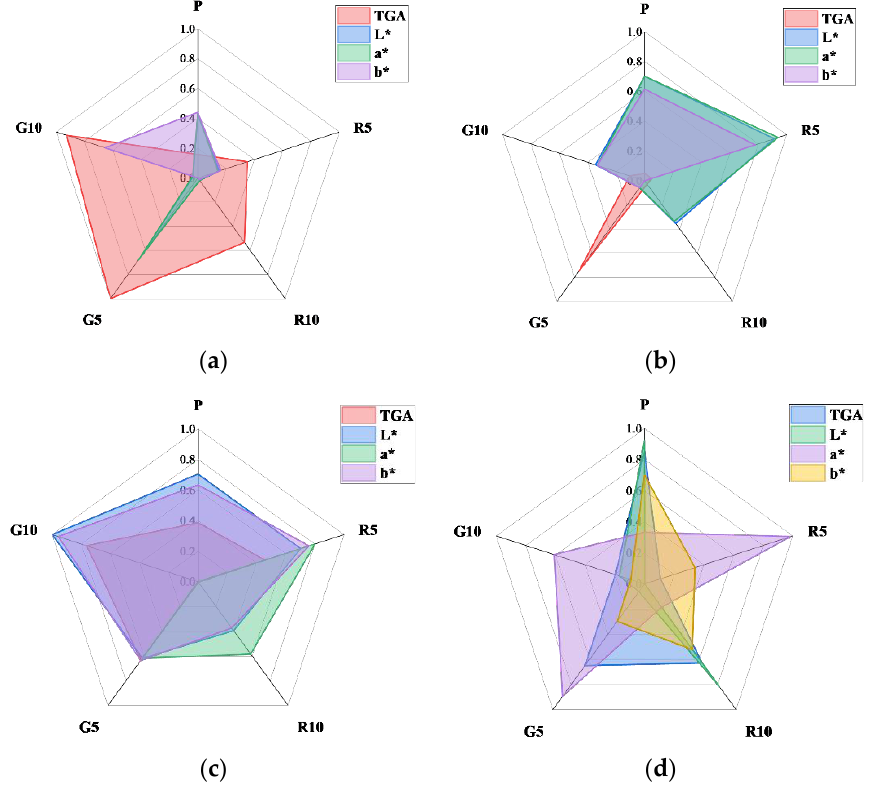
Figure 10. Specialized matrices showing the R 2 distribution of each HSCC specimen at different ages: ( a ) 3 days, ( b ) 7 days, ( c ) 28 days, and ( d ) 3 – 28 days.